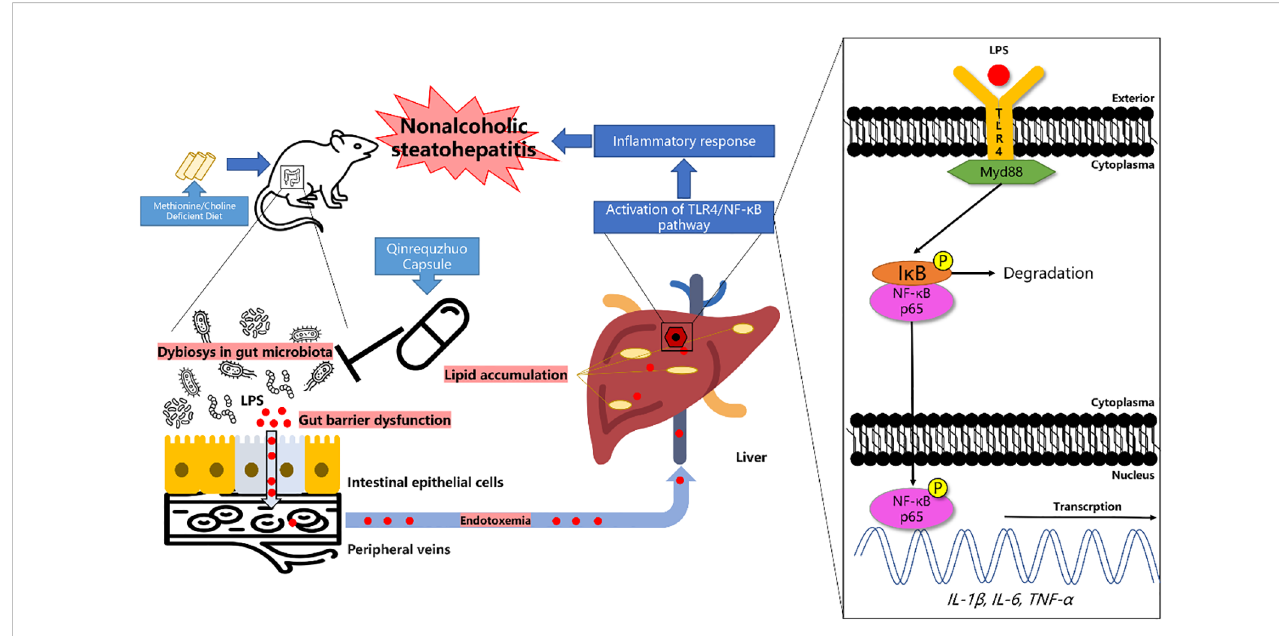
FIGURE 6 Graphical